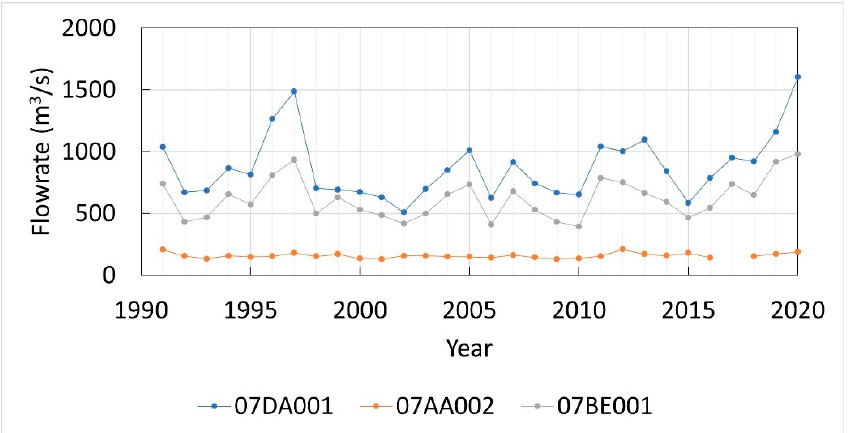
Figure 6. Time series of the open warm season average flowrate between 1991 and 2020. Analyzing 30-year windows of data that move every five years for the ARB since 1956 showed that the definition of cold and warm seasons can vary according to the climate and hydrology of the region. Possible regime shifts can be detected when analyzing the 30-year moving windows of data, which can reveal the periods when significant changes occurred. Figure 7 shows the average hydrographs of each of the 30-year windows, as well as the cold and warm season averages and the annual average for the three major stations along the Athabasca River. The remaining stations are shown in Figures S1 and S2 in the Supplementary Information. The hydrographs show that the month of April did not exhibit significant increases in water flow over the cold season months in all upper ARB stations. In the middle and lower subregions, the April water flow was significantly higher than the March water flow due to factors, such as warmer climate and flow contribution from other tributaries. For this reason, the calculation of the cold season and warm season averages for the ARB in this study was adjusted to reflect this behavior. The cold season was November to April in the ARB, while the rest of the year was considered open warm season. This was true in the upper ARB only, where the water flow in April was consistent with freezing conditions. The middle and lower ARB had high water flow measurements in April, which led to moving April to the warm season in these two subregions. Stations 07GE001, 07GJ001, and 07KC001 are located on the Peace River with long- term and almost continuous historical records and in comparable locations to stations 07AD002, 07BE001, and 07DA001 along the Athabasca River, i.e., they are considered as a proxy for subregions of the Peace River Basin. Figure S2 includes the hydrographs of stations 07GE001, 07GJ001, and 07KC001. The hydrographs show that the Peace River has similar flowrates to the Athabasca River in the upper and middle subregions, but its lower subregion flowrate is higher. The Peace River had a consistent November-to-March cold season in its upper, middle, and lower reaches. Another observation was that the water flow in the cold months was significantly higher in the Peace River than in the Athabasca River. The contribution of each of the upper, middle, and lower ARB subregions to the outlet water flow was calculated as percentages and shown in Figure 8. The only downstream WSC gauge station near the outlet of the Athabasca River, and with recorded water dis- charge data, was the Athabasca River Near Embarras Airport station (07DD001). The other stations used for representing the subregion contributions were the Athabasca River stations at Hinton (07AD002), Athabasca (07BE001), and below Fort McMurray (07DA001). Due to the presence of several data recording gaps, the only years where all four stations had complete annual recorded data were 1972, 1973, 1975, 2015, 2018, and 2019. These years were used to calculate the average water flow for each month and seasonal average and were plotted with the outlet water flow at Embarras Airport being 100%. Tables 6 and 7 show the average flow percentages split according to the decade of available